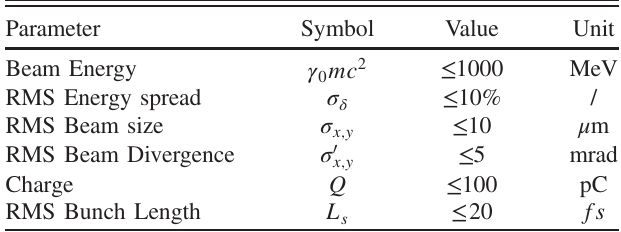
TABLE I. Beam parameters from